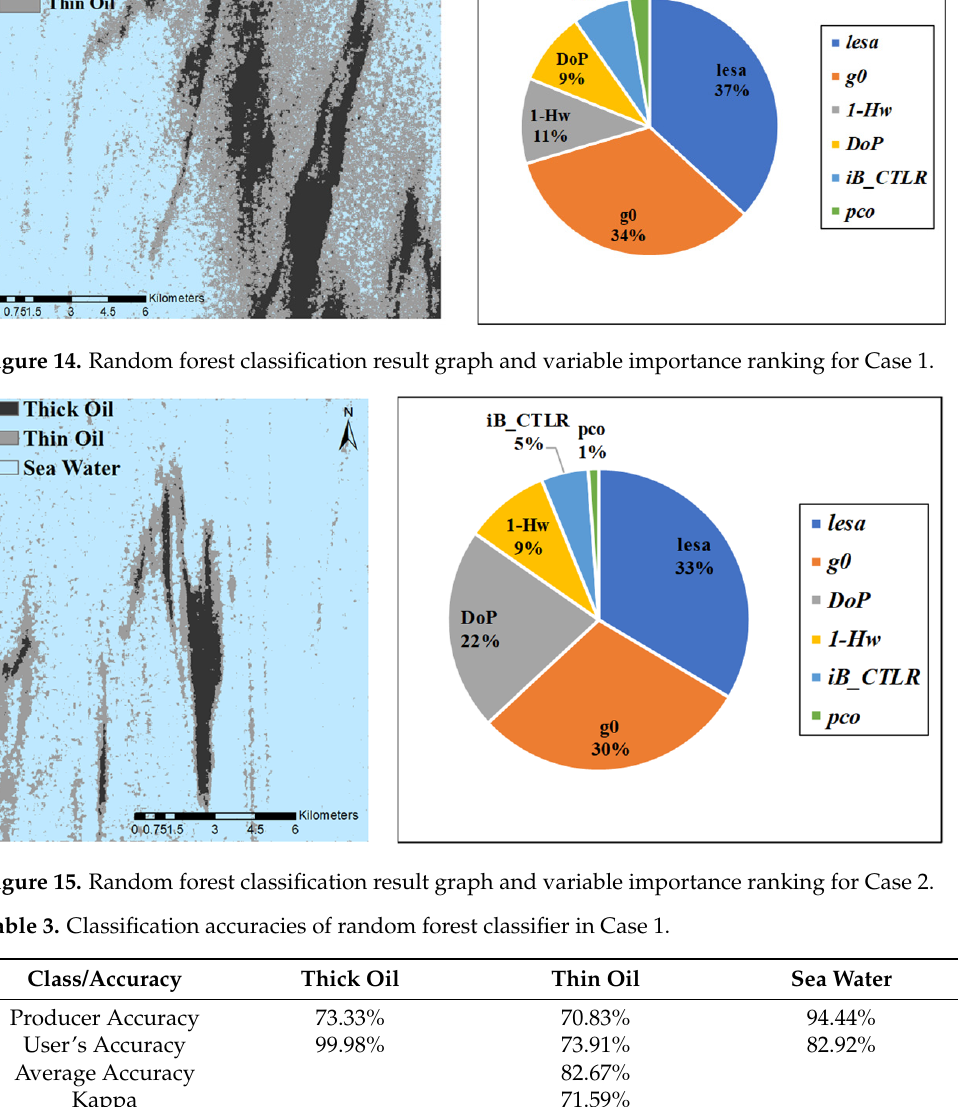
Table 4. Classification accuracies of random forest classifier in Case